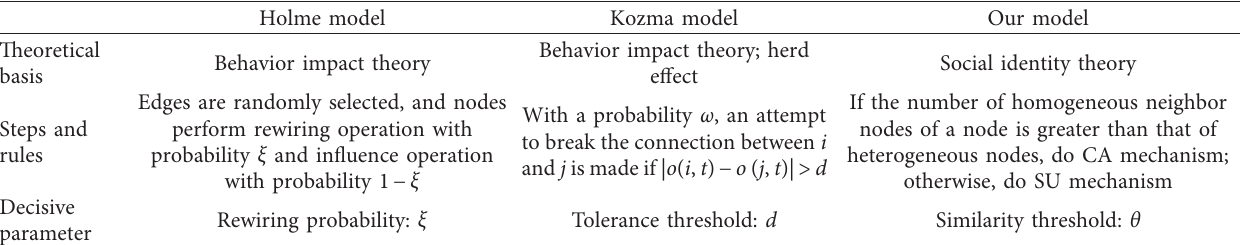
Table 1: Model comparison.